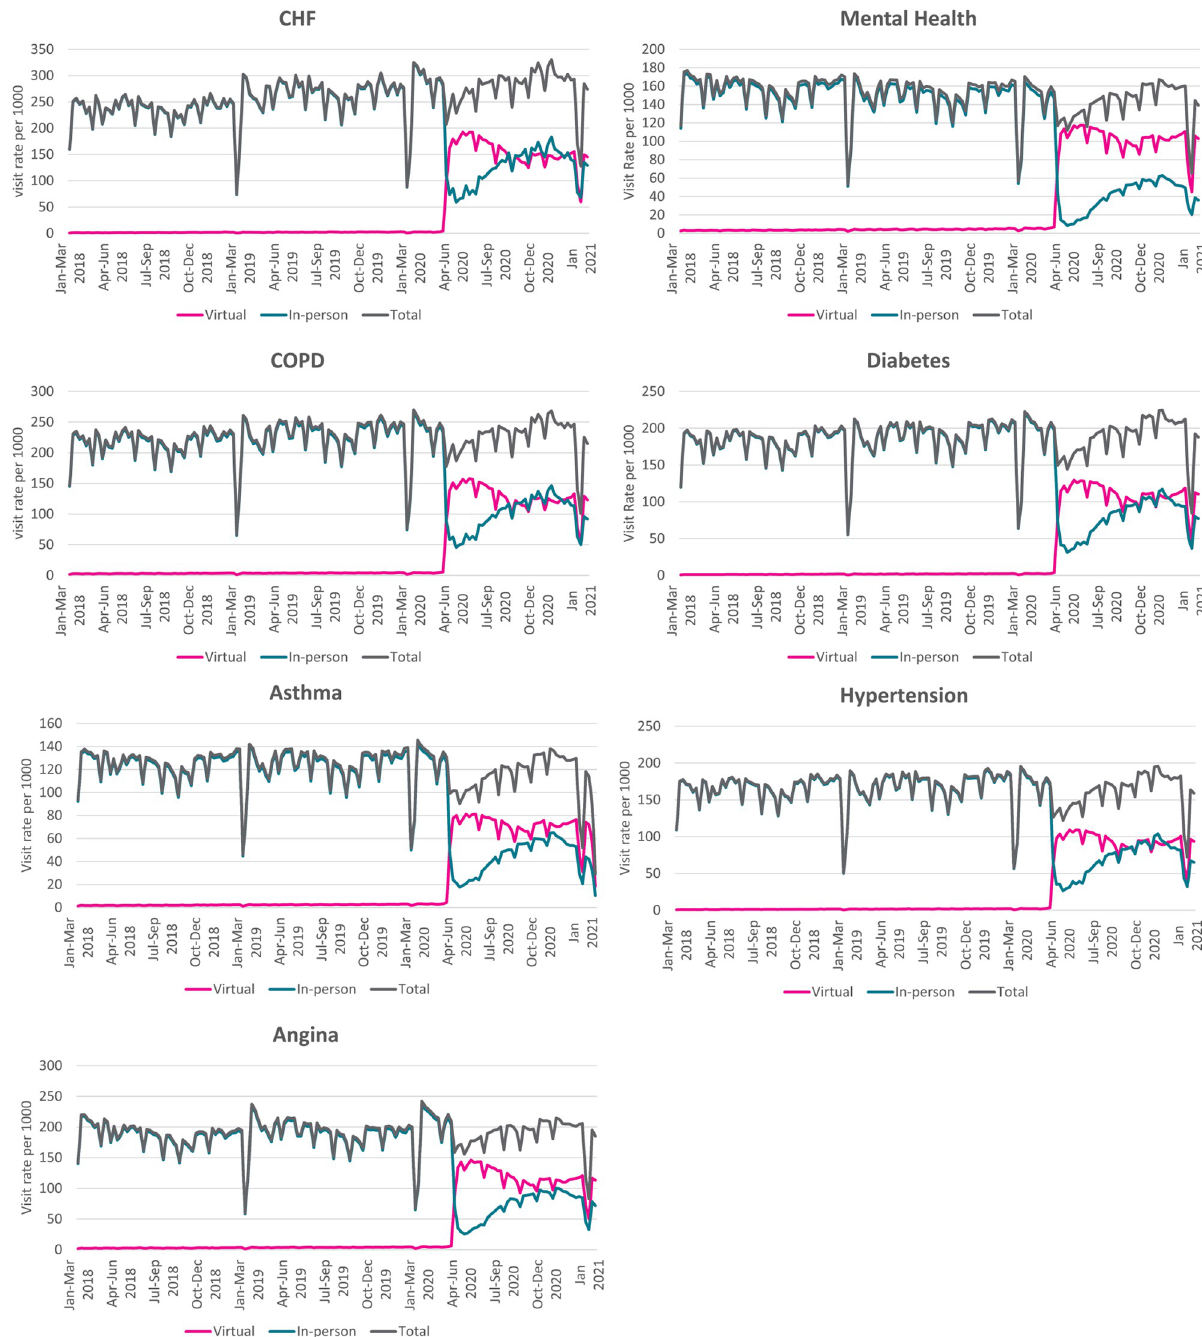
Fig 2. Weekly rate of virtual and in-person care visits per 1000 by medical